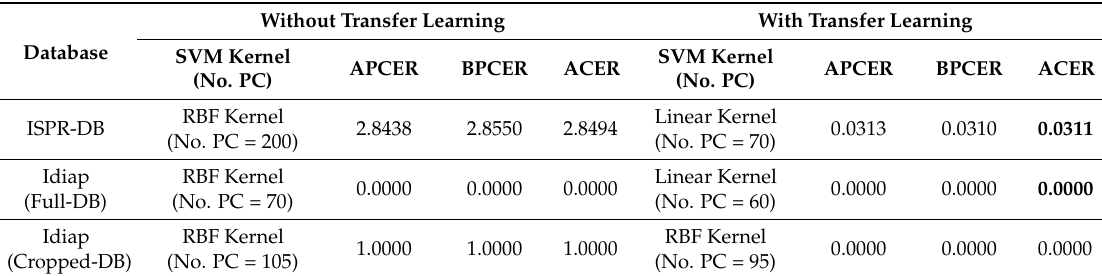
Table 13. Detection errors of our proposed method with and without applying the transfer learning technique using VGG-16 network architecture in Table 4 (unit: